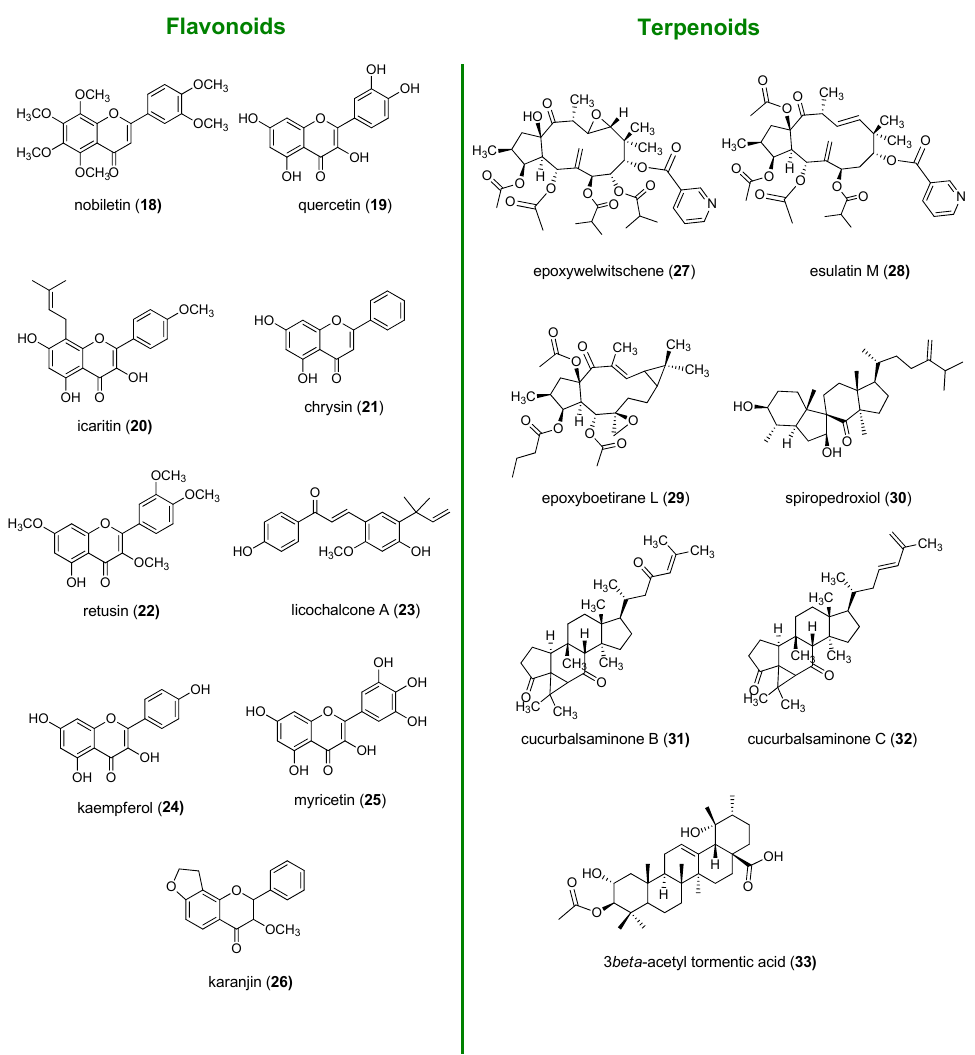
Figure 4. Selected naturally occurring flavonoids and terpenoids with ABC transporter modulator Figure 4. properties.